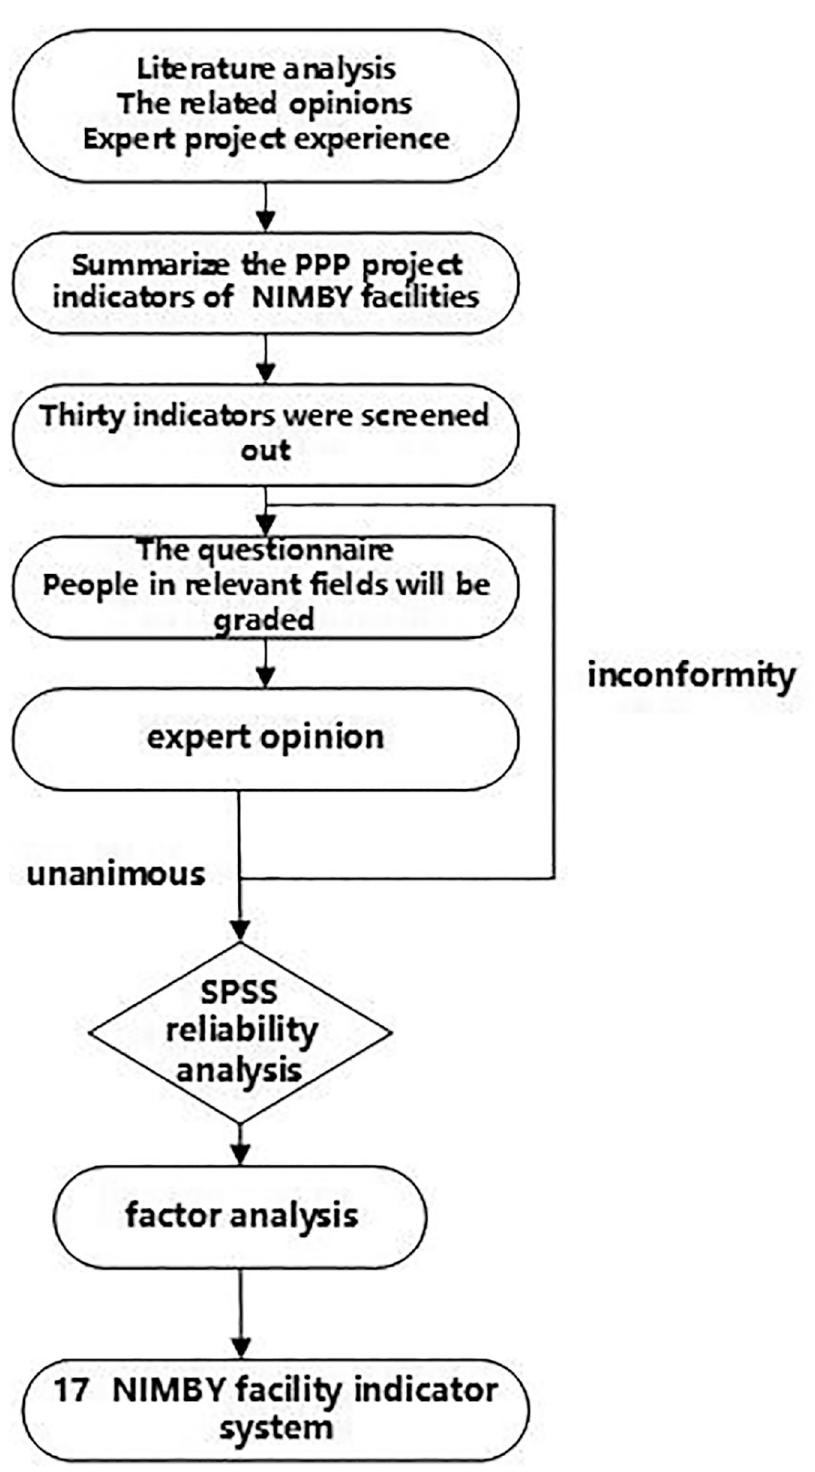
Fig 2. Confirmation process of the index system. The picture shows the confirmation process of the index system from top to bottom. It is worth noting that if the experts have different opinions on the 30 indicators, they will re- discuss and re-score them until they reach a consensus and proceed to the next